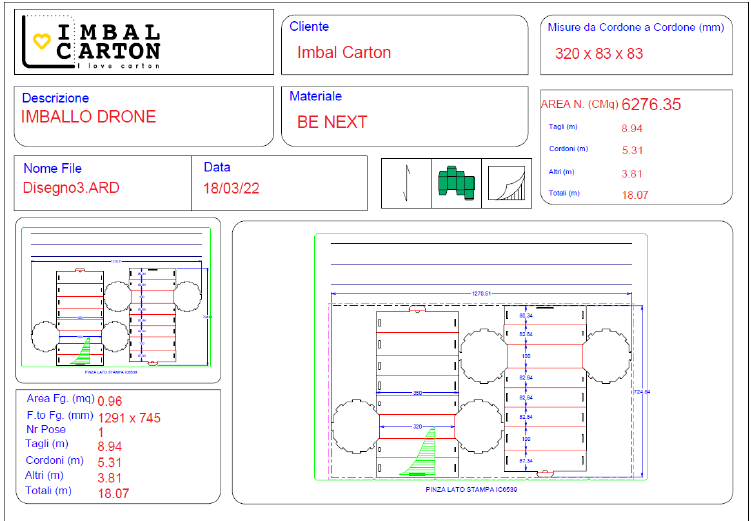
Figure 3. Technical drawing of the sheet layout for die-cutting machining.